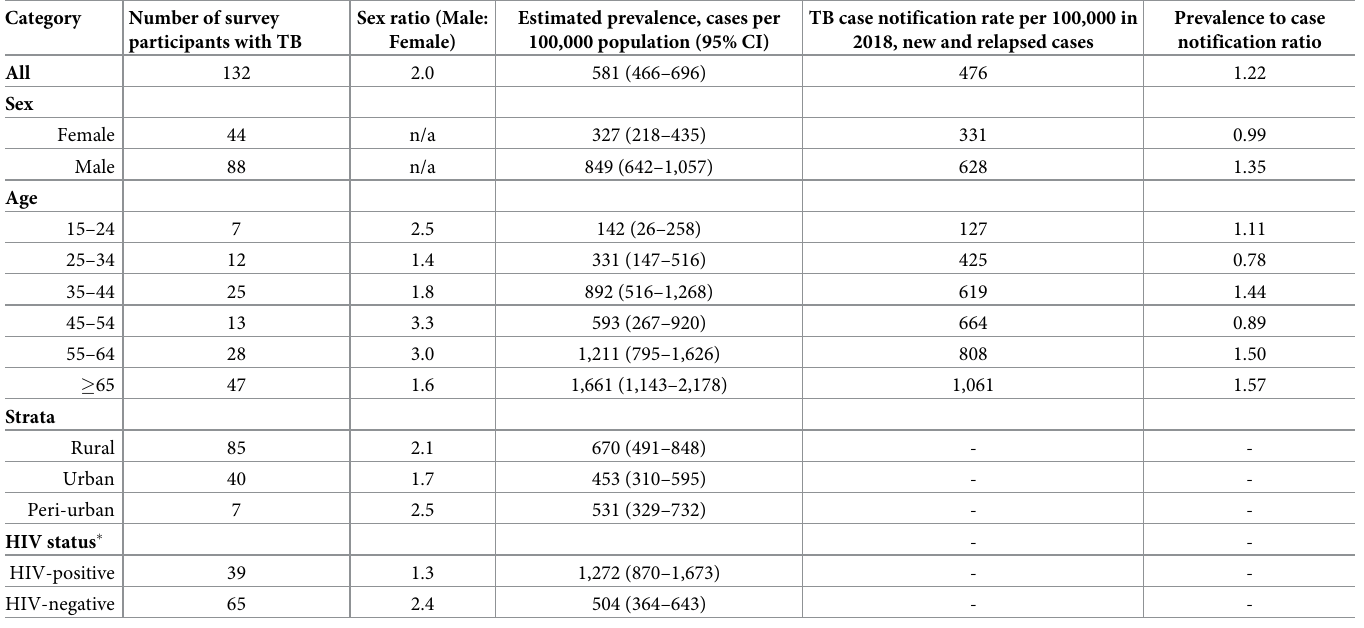
Table 4. Estimated prevalence of bacteriologically confirmed pulmonary TB among individuals aged � 15 years, and prevalence to case notification